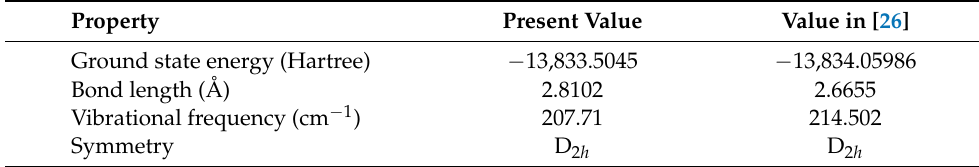
Table 3. Ground-state properties of I 2